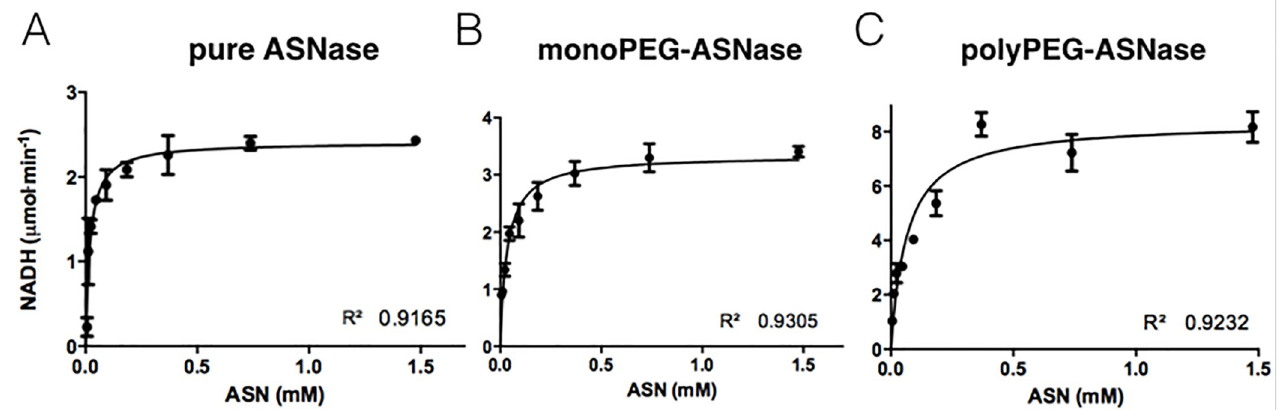
Fig 2. Enzymatic behavior of monoPEG-ASNase compared to ASNase (control) and polyPEGylated form. ( A ) Enzymatic kinetics of ASNase. ( B ) Enzymatic kinetics of monoPEG-ASNase. ( C ) Enzymatic kinetics of polyPEG-ASNase. Data analysis and statistical analysis (F-test) were done using GraphPad Prism 5.0 software. All trials were in triplicates and error bars represent the standard deviation.